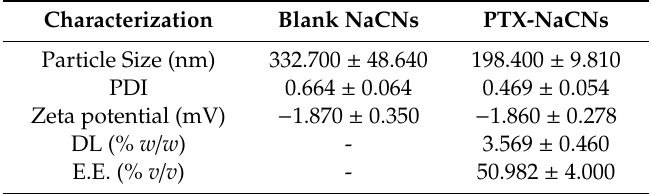
Table 1. Characteristic of Blank and PTX-NaCNs.